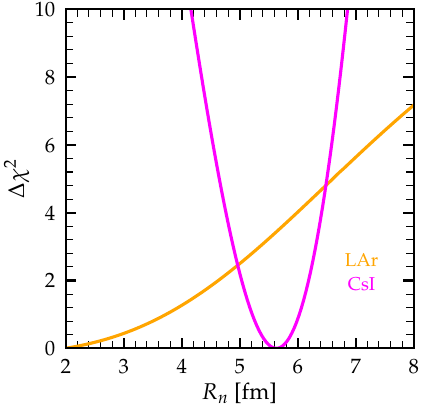
Figure 1 . Left panel: ∆ χ 2 profile for sin 2 θ W obtained from the analysis of CsI (magenta), LAr (orange) and CsI + LAr (blue) data. Right panel: sin 2 θ renormalization scheme (light red line), compared with our CsI + LAr determination (blue) and other measurements at different scales.